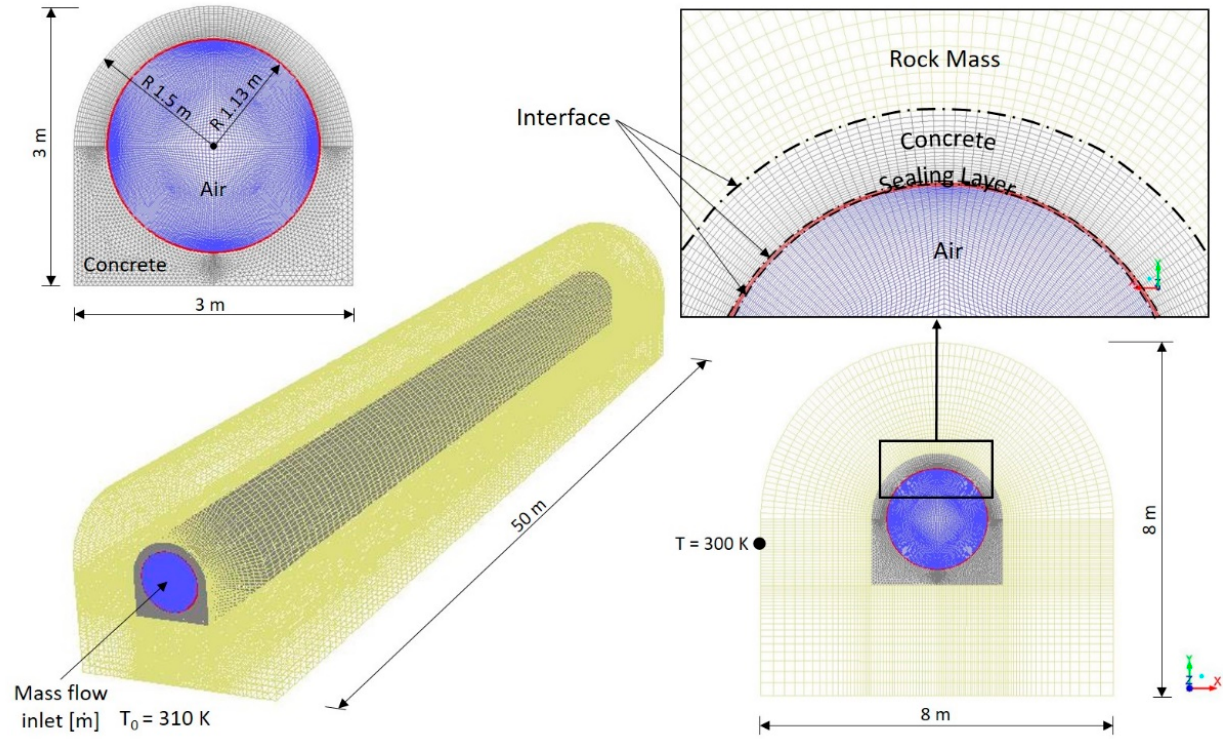
Figure 3. Computational domain. Mesh and boundary conditions used in CFD simulations.